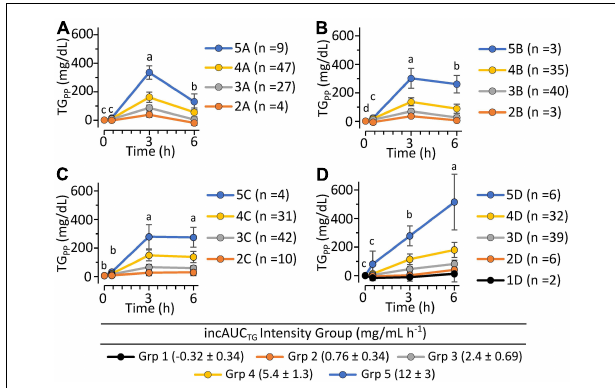
FIGURE 6 | The postprandial triglyceride incremental area under the curve x kinetic response patterns of 340 clinically healthy free-living individuals. Triglyceride kinetic response types A, B, C, and D are defined by the quartiles of the Johnson Su [(k EP x k LP )/incAUCTG], which describes the product of the 0 to 3 h and 3 to 6 h triglyceride rates of change in relation to the incremental area under the triglyceride curve. The range of the population-wide